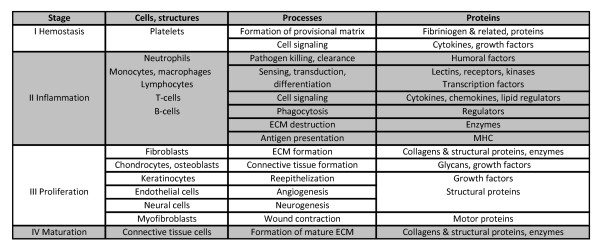
A schematic description of wound healing. Four phases are presented in a chronological order.